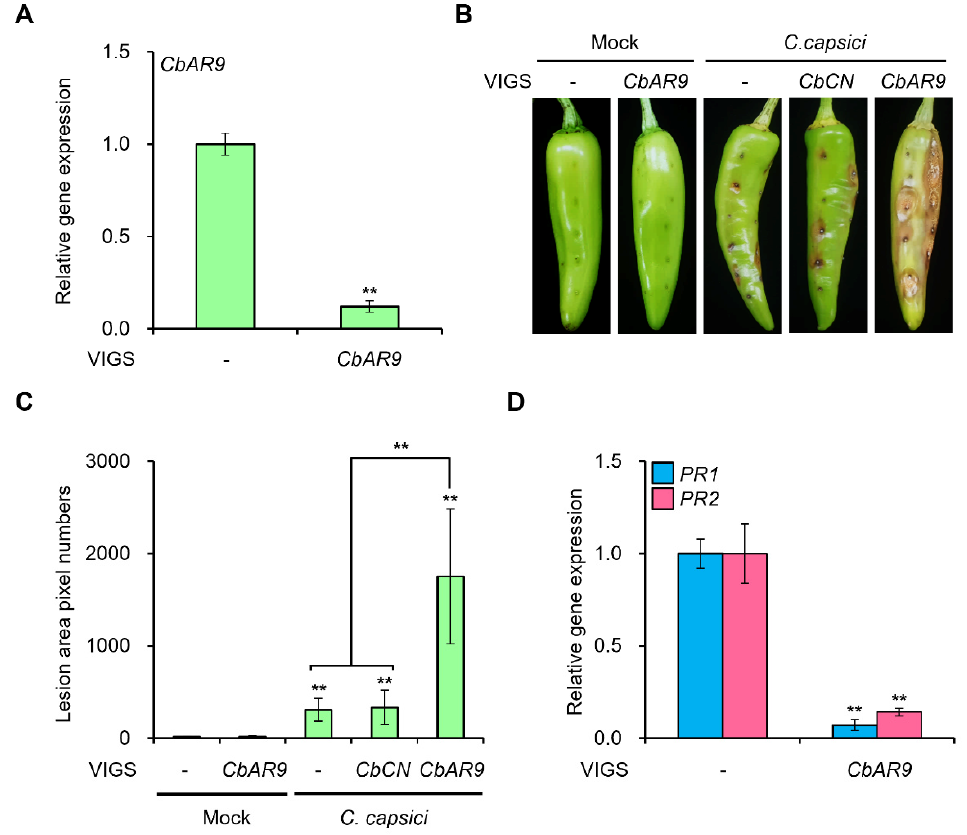
Figure 4. CbAR9 -silenced chili pepper fruits are more susceptible to anthracnose after Colletotrichum capsici infection. ( A ) Relative transcript levels of CbAR9 in control chili pepper fruits and CbAR9 - silenced fruits for the PBC80 infected with C. capsici . Relative CbAR9 transcript levels were determined by RT-qPCR with Actin as an internal reference. Data are shown as means ± SD. Asterisks indicate statistically significant differences from controls (** p < 0.01). The experiments were repeated at least three times, with similar results. ( B , C ) Anthracnose disease resistance assays with wild-type and VIGS-mediated CbAR9 -silenced chili pepper fruits after C. capsici infection. CbAR9 -silenced and wild-type chili pepper fruits were inoculated with C. capsici . Images were taken 6 days later, and the extent of the disease area was quantified using the image-based plant disease phenotyping method. Data are shown as means ± SD. Asterisks indicate statistically significant differences from controls (** p < 0.01). ( D ) Relative PR1 and PR2 transcript levels in CbAR9 -silenced and wild-type chili pepper fruits after C. capsici infection. Actin served as the internal reference. Data are shown as means ± SD. Asterisks indicate statistically significant differences from controls (** p < 0.01). The experiments were repeated at least three times, with similar results.